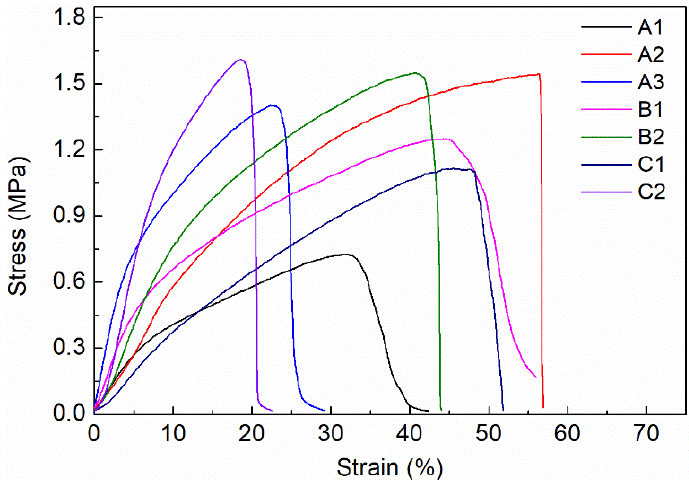
Figure 4. Stress–strain curves of different coated nonwovens.